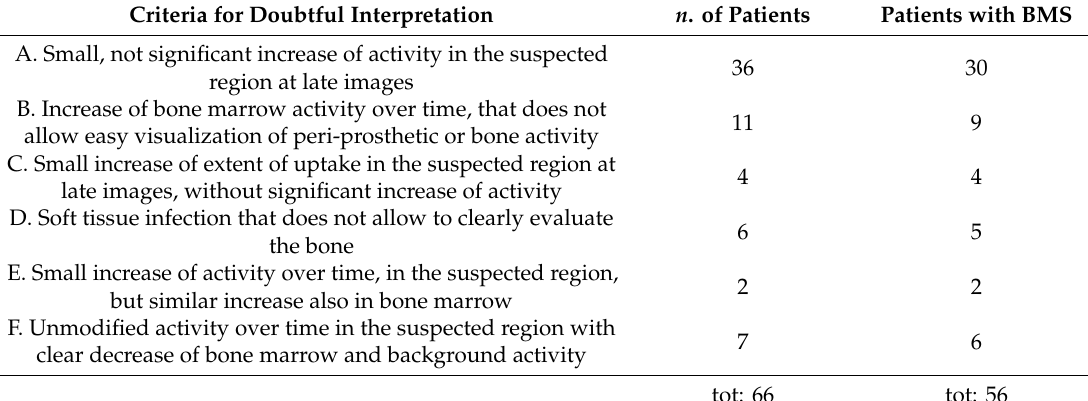
Table 2. Distribution of patient population according to doubtful